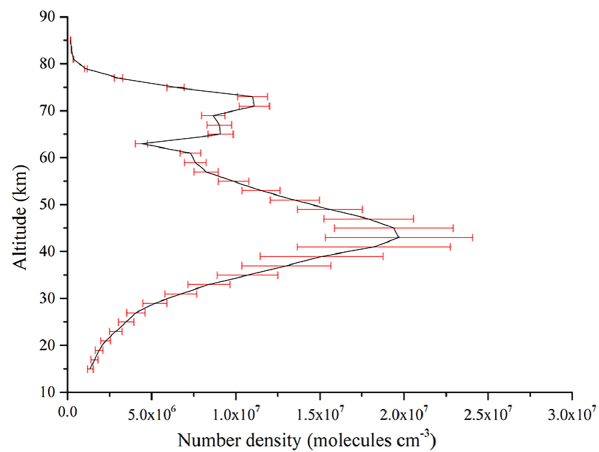
Figure 21. Total errors in inversion results caused by some factors mentioned in the text. The red error bars indicate the relative errors caused by some factors mentioned in the